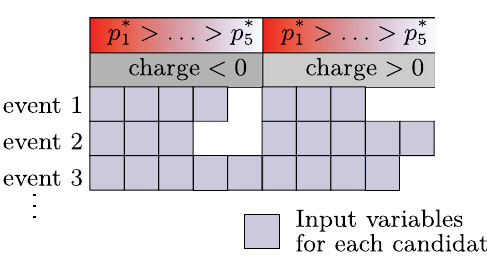
Fig. 2 Procedure for each single category (green box): the candidates correspond to the reconstructed tracks for a specific mass hypothesis. Some of the input variables consider all reconstructed tracks and all neutral ECL and KLM clusters on the tag side. The magenta boxes represent multivariate methods: y cat is the output of the event level. The output of the combiner is equivalent to the product q · r . Each box